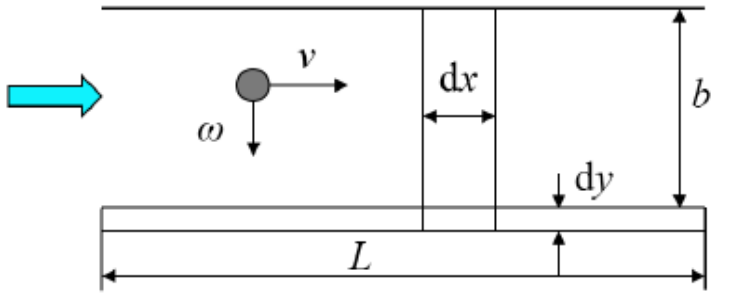
Figure 10. Schematic diagram of the movement of particles in the electric field channel.